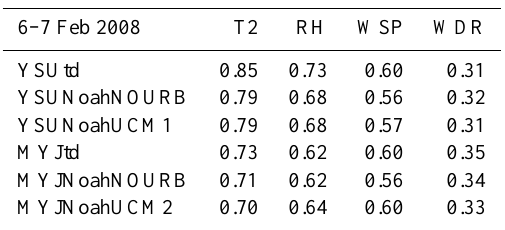
Table 3. Correlation values for WRF simulations (rows) with re- spect to SIARL stations for 2m temperature (T2), relative humid- ity (RH), horizontal wind speed (WSP), horizontal wind direction